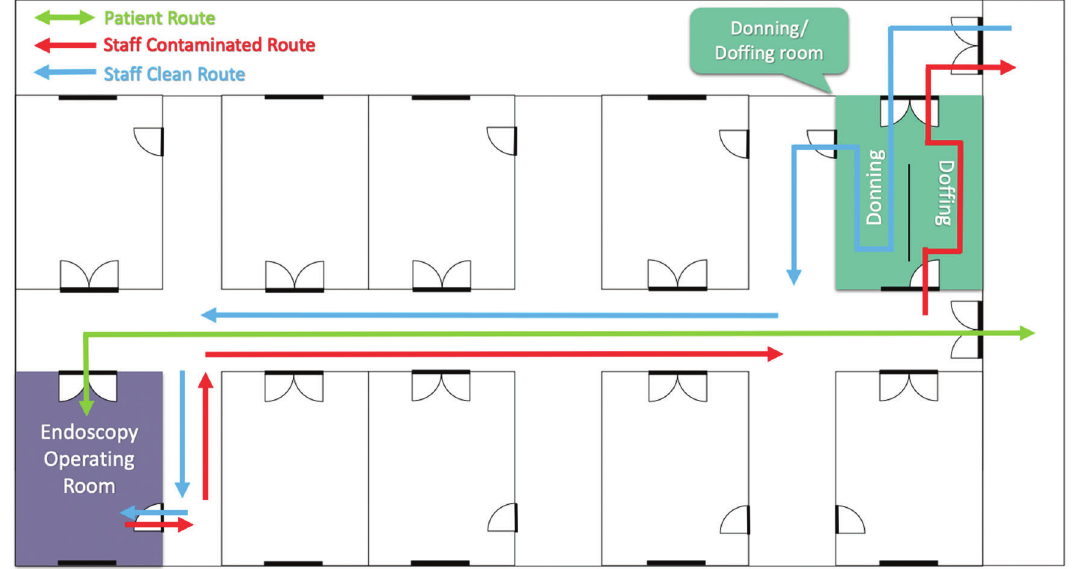
Figure 5 - Organization of the Operating Room Block for Coronavirus Disease 2019 (COVID-19) Patients. There is an exclusive operating room for endoscopic procedures. Entering and leaving the block requires passing through the dressing room. A single patient can move down the corridor at a time. According to Hospital das Clı´nicas da Faculdade de Medicina da Universidade de Sa˜o Paulo (HCFMUSP)